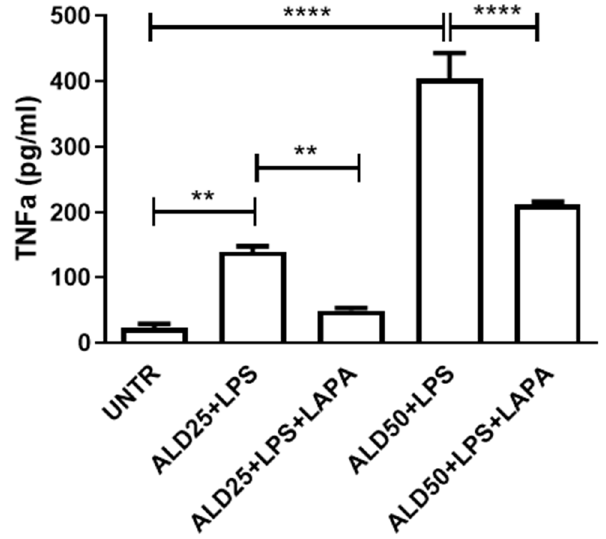
Figure 5. Analysis of TNF- α levels on supernatants of RAW 264.7 treated with ALD 25 μ M or 50 μ M plus 10 μ g/mL LPS, with or without 10 μ M Lapaquistat (LAPA). Data are expressed in pg/mL with Bonferroni post-test: ** p < 0.01, **** p < 0.0001. UNTR: untreated.